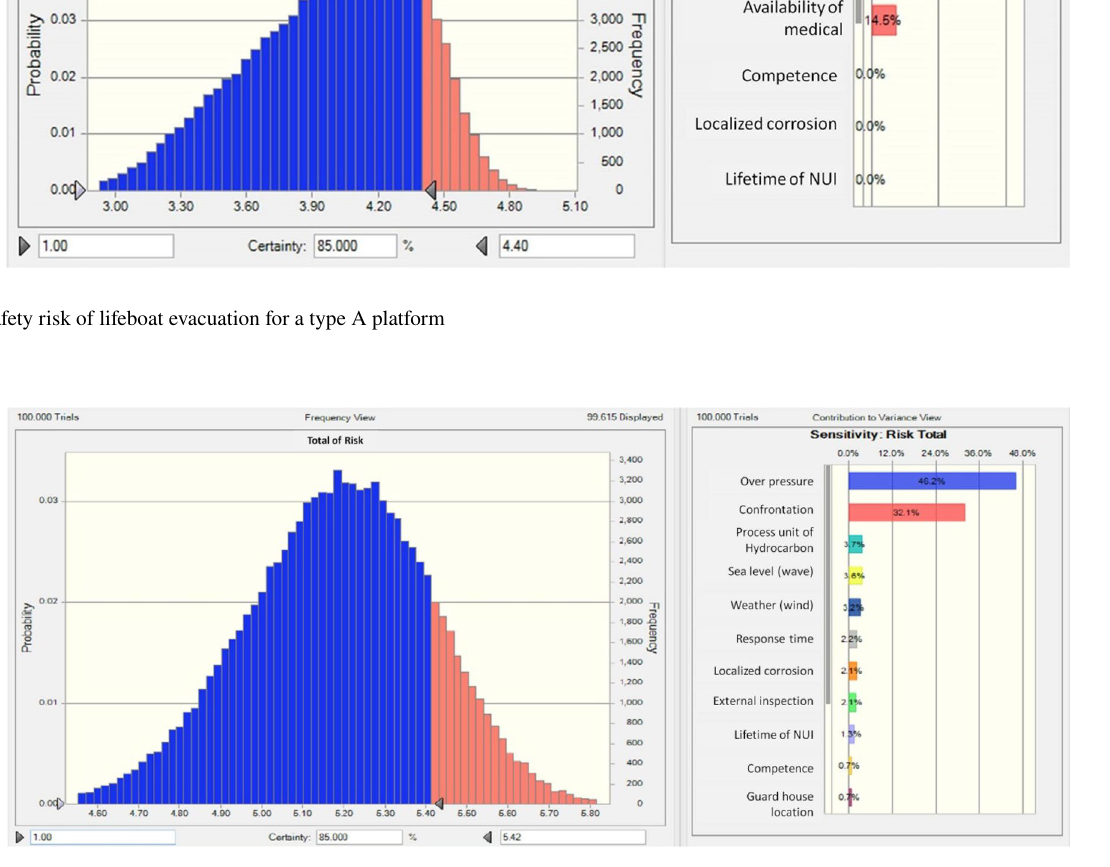
Fig. 6 Total risk values for a type A